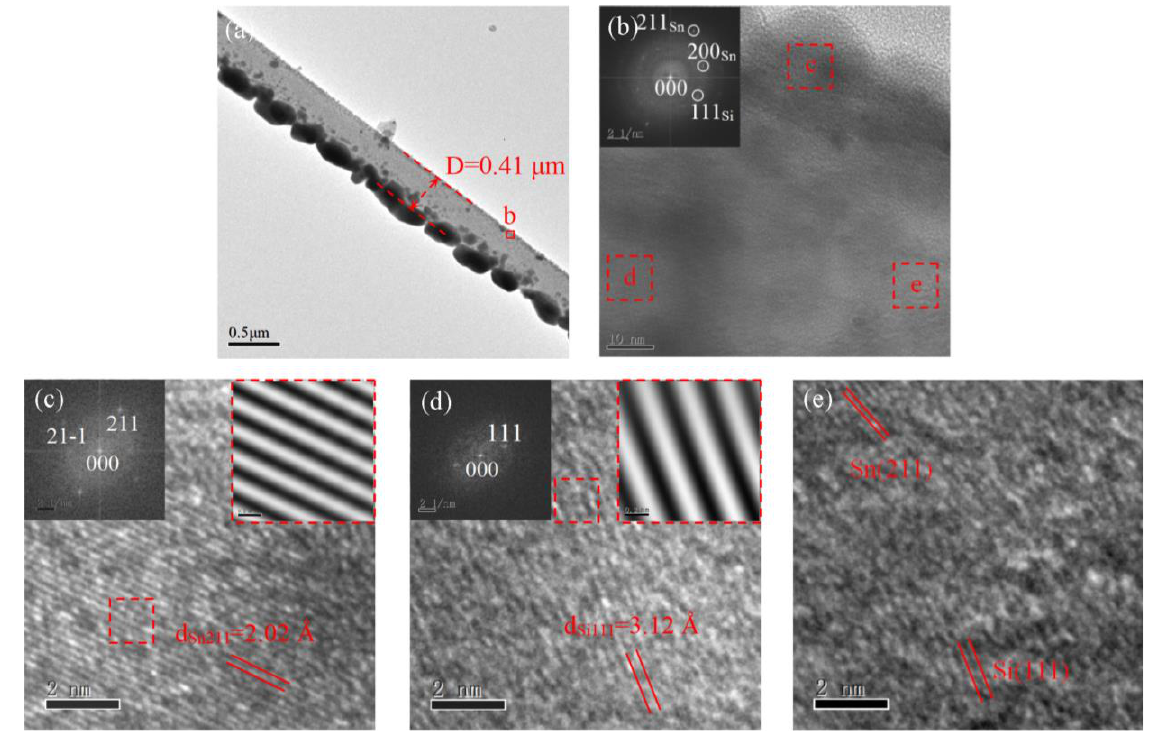
Figure 4. Bright-field TEM ( a , b ) of Si NW with asymmetric Sn layer. HRTEM image of asymmetric Sn ( c ), Si ( d ), and Si/Sn interface ( e ). The insets of panels b – d display the FFT patterns and Fourier- filtered images.